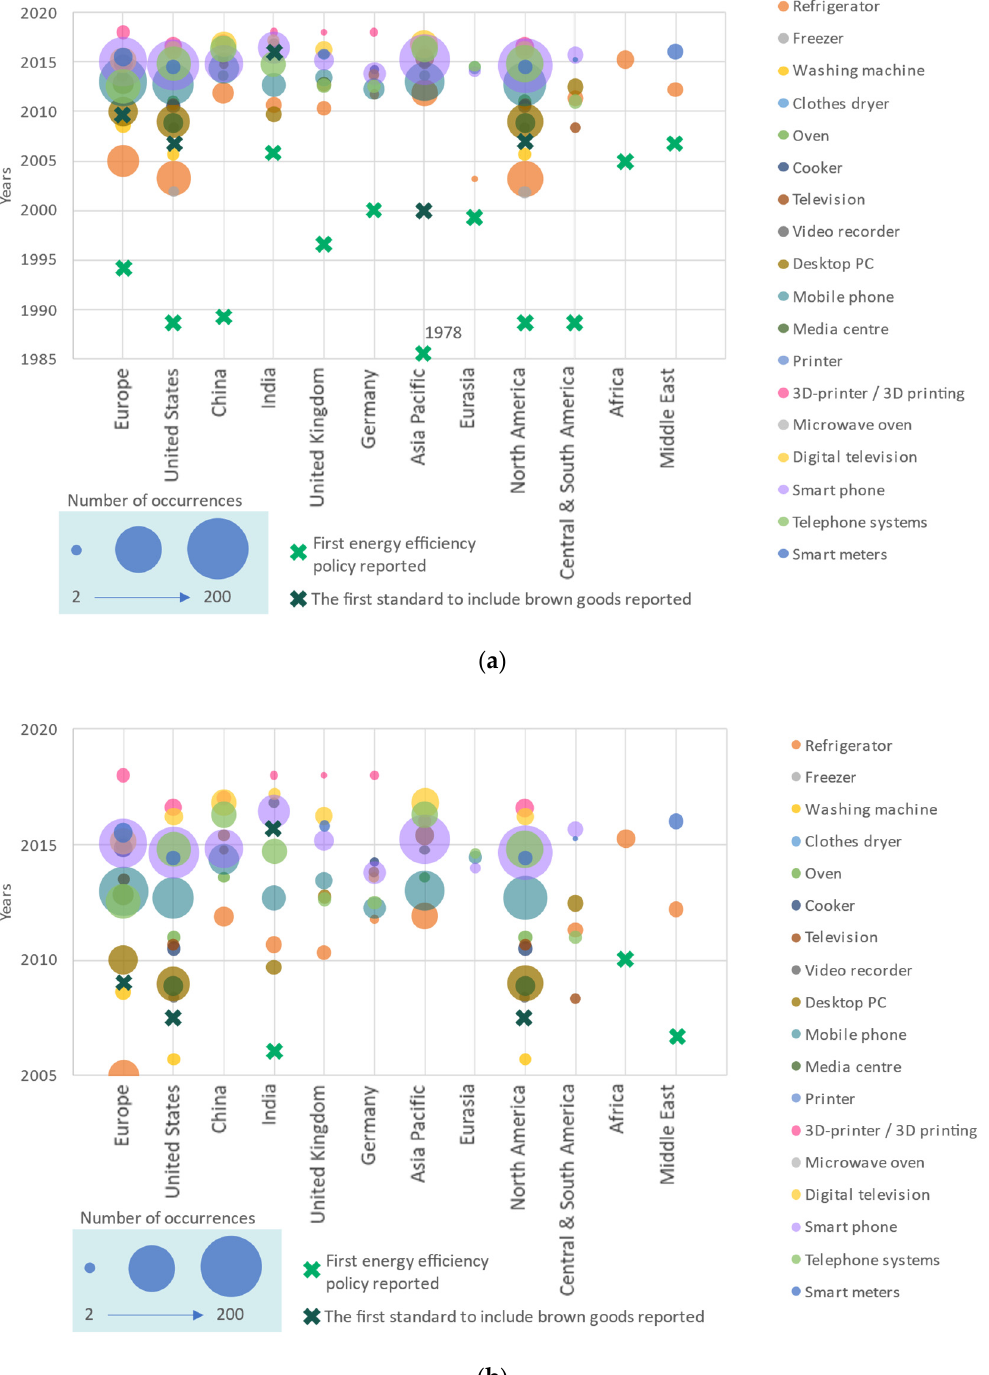
Figure 10. Average publications year and number of occurrences of the different appliances in each studied country/region. Data from the Scopus query. The green crosses indicate the first appliance efficiency standard or policy implemented in each country/region. The dark green crosses indicate the first appliance efficiency standard or policy that includes brown goods appliances. Data obtained from the IEA policies database [46], ( a ) range of years from 1985 to 2020, ( b ) year range from 2005 to 2020.